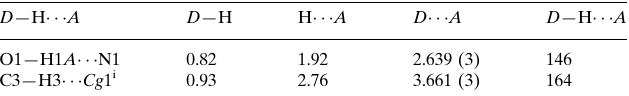
Hydrogen-bond geometry (A˚ , (cid:4)